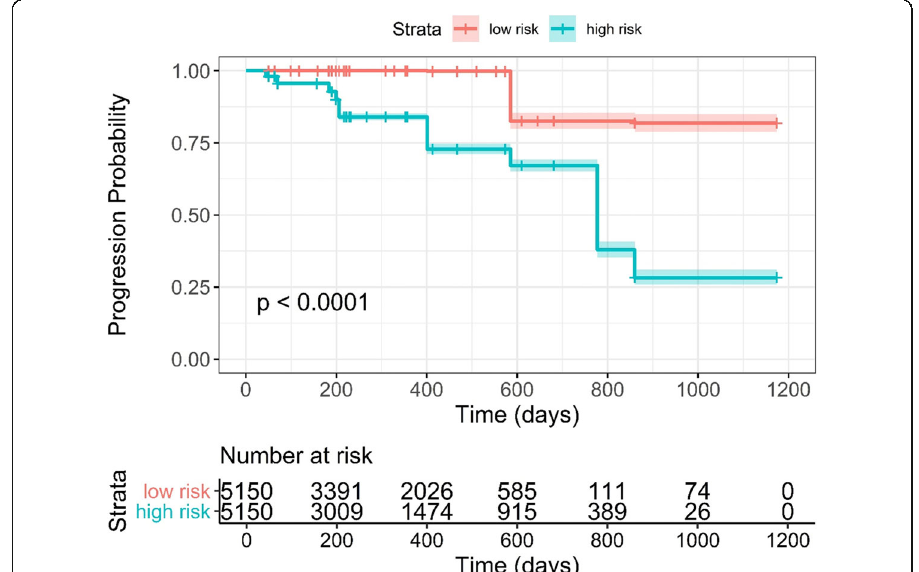
Fig. 5 Kaplan-Meier plot of the combined model for progression (absorbed dose + ZSN). This is the result of 10 times 5-fold cross validation; thus, there are more test samples than the dataset. High and low risk lesions for progression were stratified by median value of the Cox model output, with high risk group lesions having shorter time to progression, vice